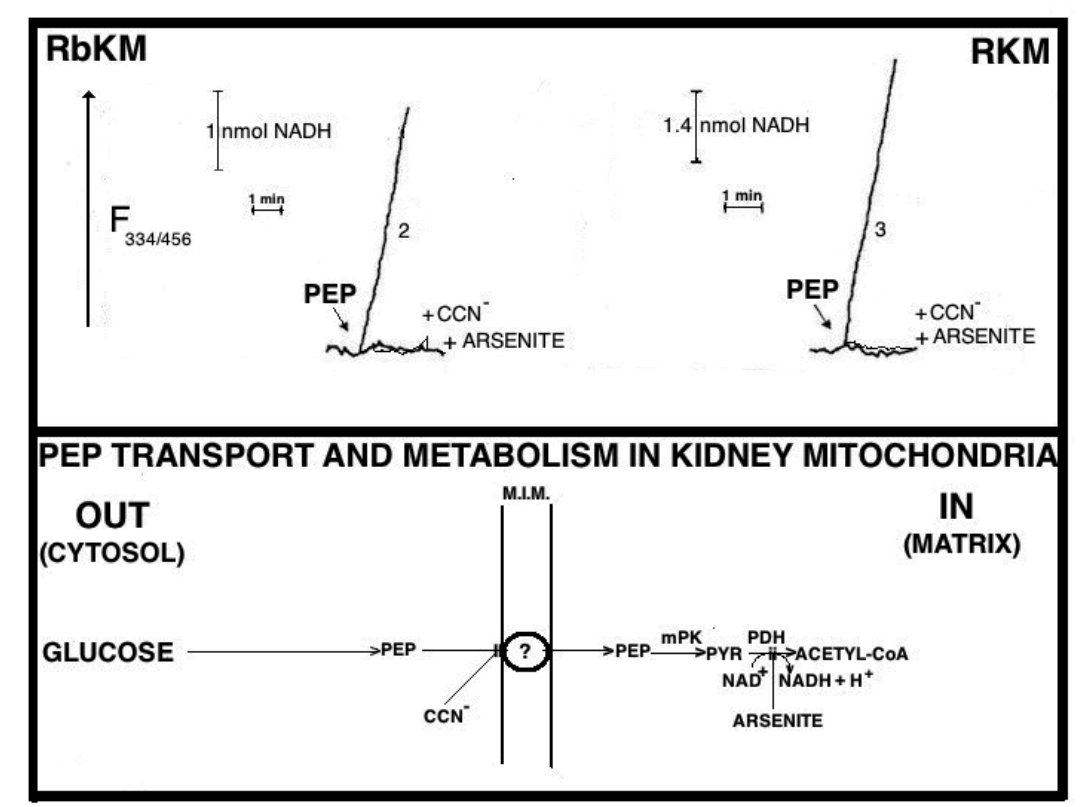
Figure 7. Phosphoenolpyruvate (PEP) can enter both rabbit and rat kidney mitochondria. From [12]. From Aracne Editrice with permission 2021. Fluorimetric investigation was made of the change in the redox state of the intramitochondrial pyridine nucleotides caused brought about by the addition of PEP. Rabbit and rat kidney mitochondria (RbKM and RKM, respectively) (2 mg protein) were suspended at 25 °C in 2 mL of standard medium consisting of 15 mM KCl, 1 mM MgCl 2 , 100 mM TRIS-HCl, pH 7.4. and the redox state of intramitochondrial pyridine nucleotides was followed fluorimetrically ( λ ex = 334 nm/ λ em = 456 nm) as a function of time. First, either RbKM or RKM were incubated for 3–5 min with FCCP (1.25 mM) and then rotenone was added (2 mg) (not shown). At the arrow, PEP (2.5 mM) was added either in the absence or presence of α -cyano-4-hydroxy-cynnamate (CCN − ) or arsenite (0.01 and 1 mM, respectively). The rate of fluorescence increase, measured as the tangent to the initial part of the progress curve, is expressed as nmol of intramitochondrial NAD(P) + reduced/min × mg protein. PEP uptake by mitochondria was prevented in the presence of either α -cyano-4- hydroxycynnamate (CCN − 10 µ M), or benzylmalonate (5 mM) (not shown), which can inhibit a variety of carriers. These simple experiments have produced the first evidence that mammalian mitochondria contain their own PK and showed that mitochondrial PEP transport occurs in a carrier-mediated